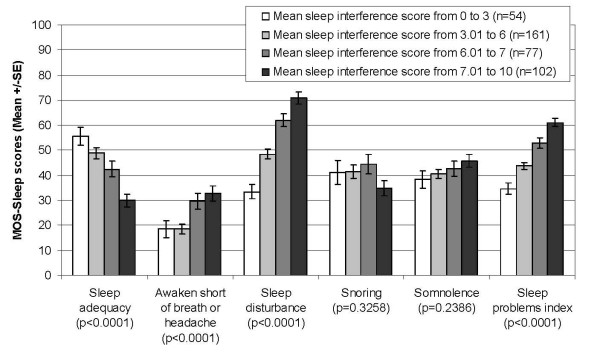
MOS-Sleep scores according to the mean sleep interference score at baseline; SE: Standard Error; p: Kruskal-Wallis p-value for between-group comparison.